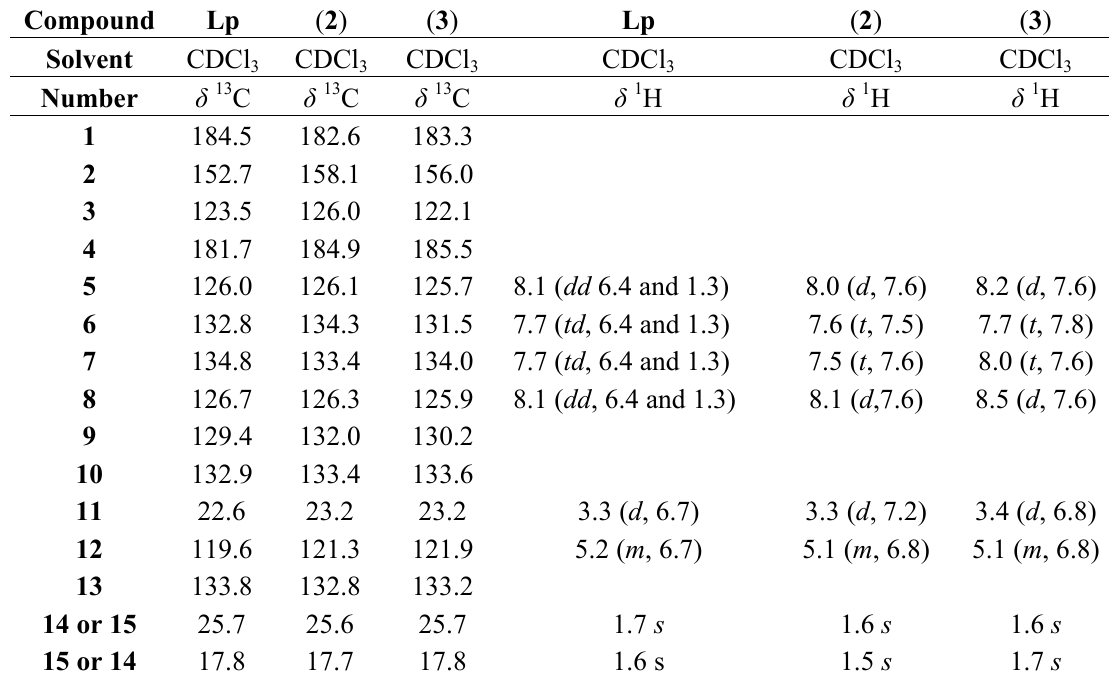
Table 1. 1 H- and 13 C-NMR data of lapachol (Lp, 1 ) and (Lp)(Ph (Lp) (Ph Bi) O ( 3 2 3 2